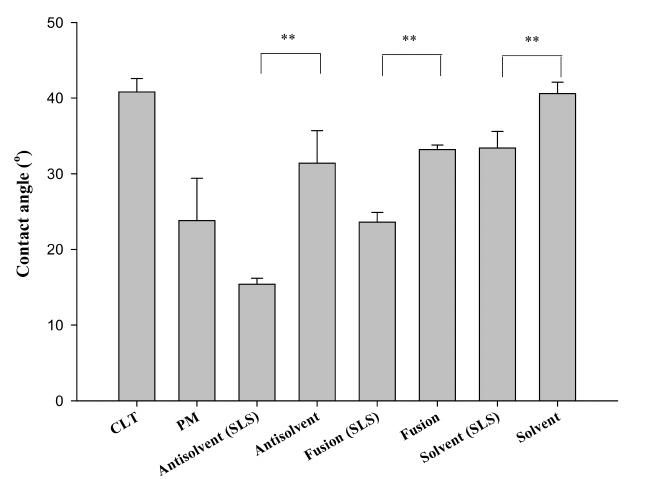
Figure 6. Contact angle of pure cilostazol (CLT), physical mixture (PM), and SDs (solid dispersions). (**: p <